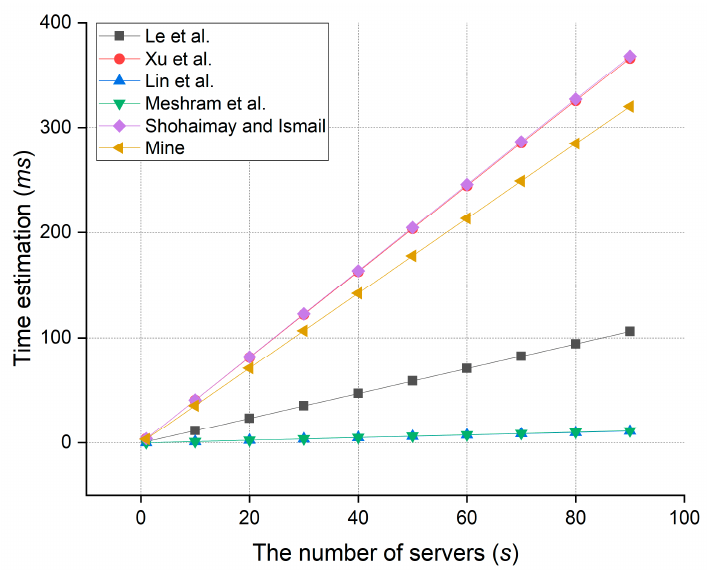
Figure 7. Computation costs of communications between a single patient and multiple servers [22,24–27].